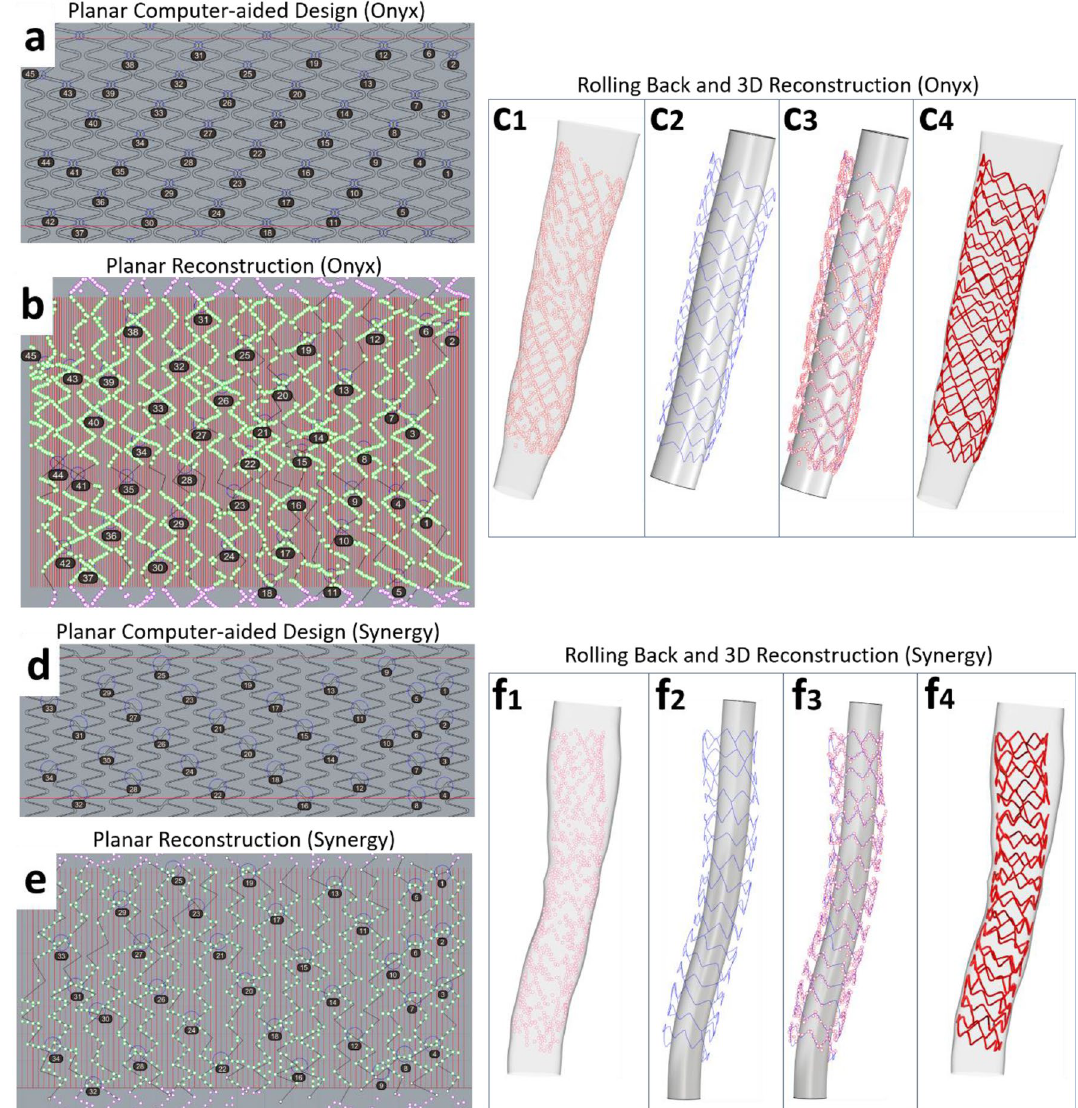
Figure 3. Planar stent wireframe reconstruction and rolling back to space. Planar computer-aided design of (a) Onyx stent and (d) Synergy stent with the boundaries delineated by red lines. Planar stent reconstruction (black lines) of (b) Onyx and (e) Synergy using the unrolled stent strut points and computer-aided stent designs as reference. The numbers and circles in (a, b, d, e) indicate the location of stent links. Note the extension of black lines beyond the stent boundaries to show the stent continuity for the next steps. Rolling back of 2D reconstructed (c) Onyx stent wireframe and (f) Synergy stent wireframe and volume creation: (c1, f1) 3D reconstructed lumen used as a backbone for the 3D stent reconstruction. The red points are segmented stent strut points, (c2 , f2) 3D rolling-back of 2D reconstructed stent wireframe (blue) following the lumen shape, (c3 , f3) Original strut points (red) overlapped on the rolled back stent wireframe, (c4 , f4) Final stent volume generated from stent wireframe. A tube was added inside the stent wireframe for better visualization (c2, c3, f2, f3 ). Stent designs were provided by the stent